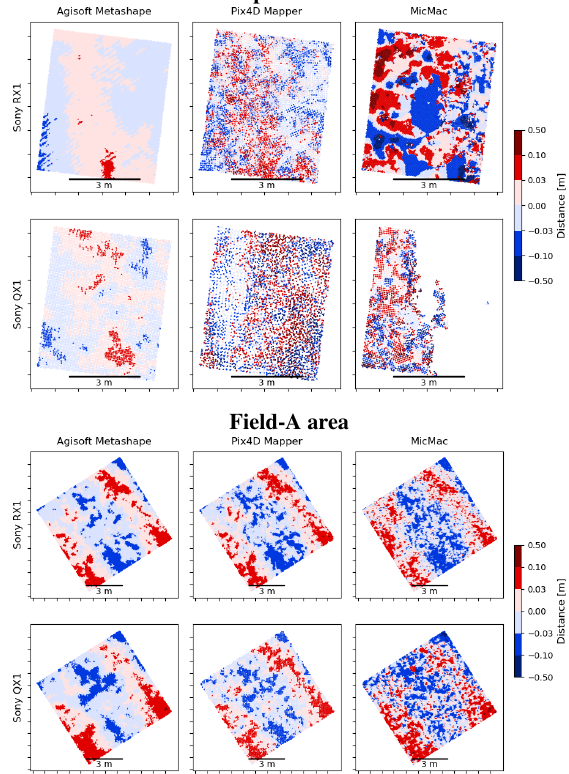
Figure 4: Dense clouds noise comparison by camera and software on two areas: Asphalt area (top), and Field area (bottom). software used. When looking at more contrasted areas, such as field and gravel, this difference is no more relevant. Thus, a better camera sensor (like Sony RX1), allows to get more precise point cloud (with lower noise level) on homogeneous surfaces ( e.g. , asphalt), when lower quality sensor (Sony QX1), gives similar results on heterogeneous surfaces ( e.g. , field or